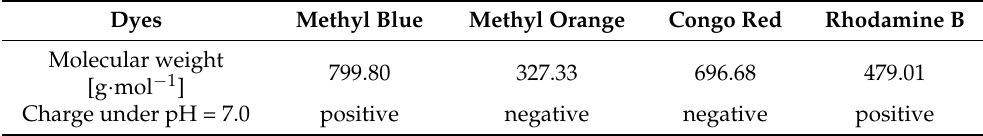
Table 3. Molecular weight and charged property of different dyes.